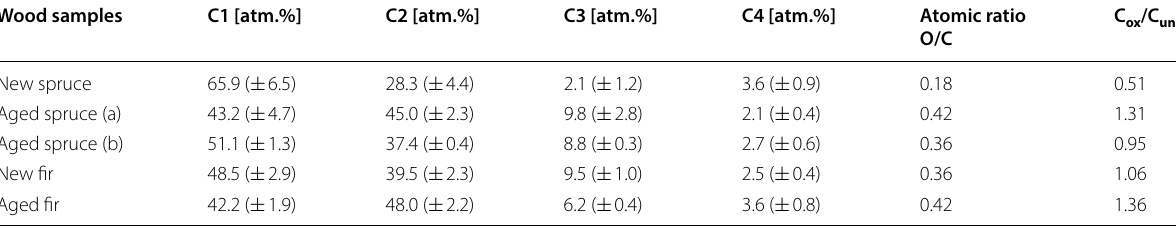
Table 3 Relative surface composition for new and aged samples of spruce and fir Wood